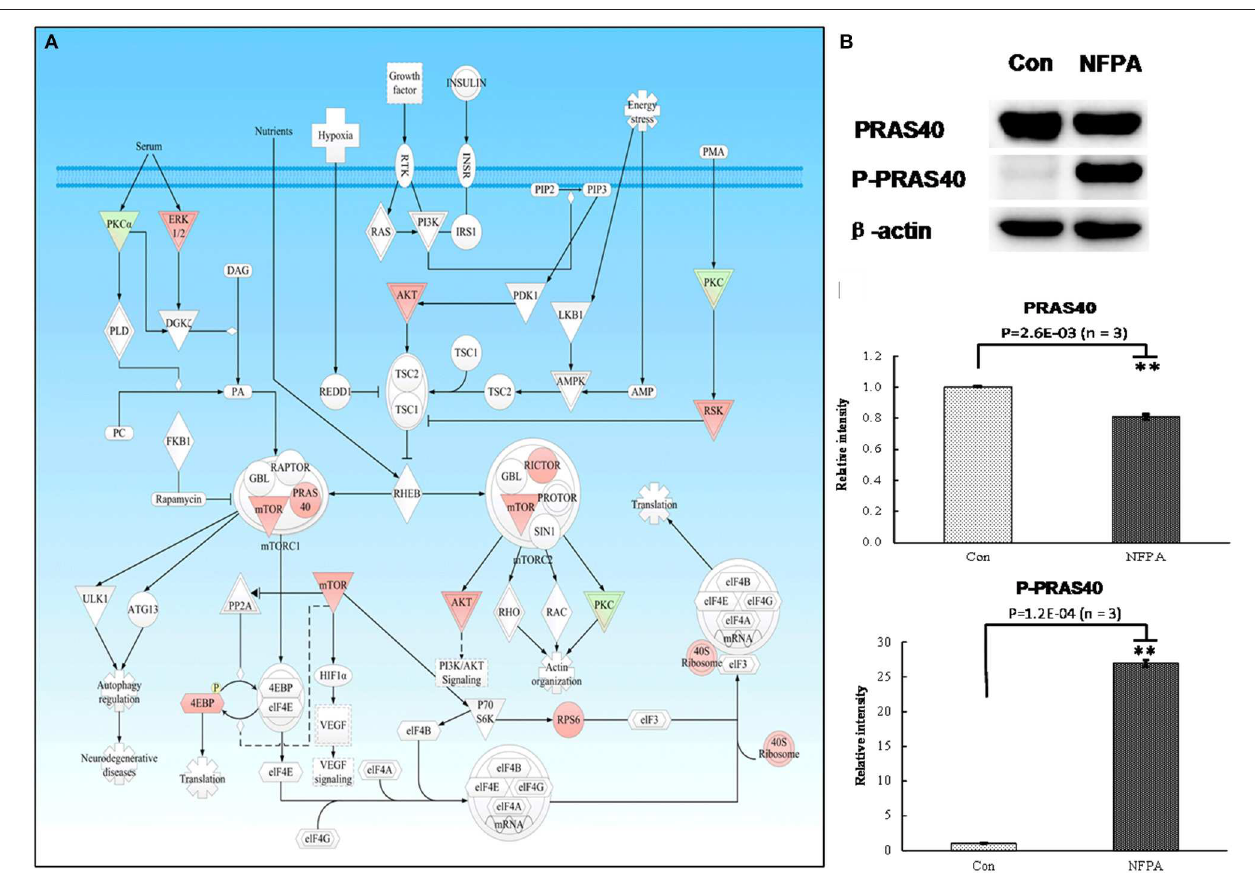
FIGURE 4 | mTOR signaling pathway was involved in NFPA. (A) mTOR signaling pathway was derived from the IPA analysis results of multi-omics, and then it was modified and verified according to the PTMScan results of NFPAs compared to controls. The red color means upregulation of a molecule in NFPAs, and the green color means downregulation of a molecule in NFPAs. The gradient color degree means slightly different expression tendency of that molecule. (B) Immunoaffinity Western blot analyses of PRAS40 and p-PRAS40 (Thr246) confirmed. mTORC1 signaling was involved in NFPAs ( n ≥ 3). The relative intensity was the ratio of absorbance units of NFPAs compared to controls. ** p <